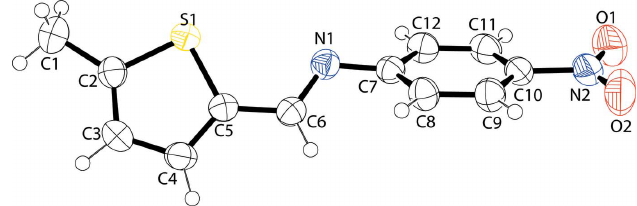
Figure 1 The molecular structure of the title compound with displacement ellipsoids drawn at the 50% probability level.